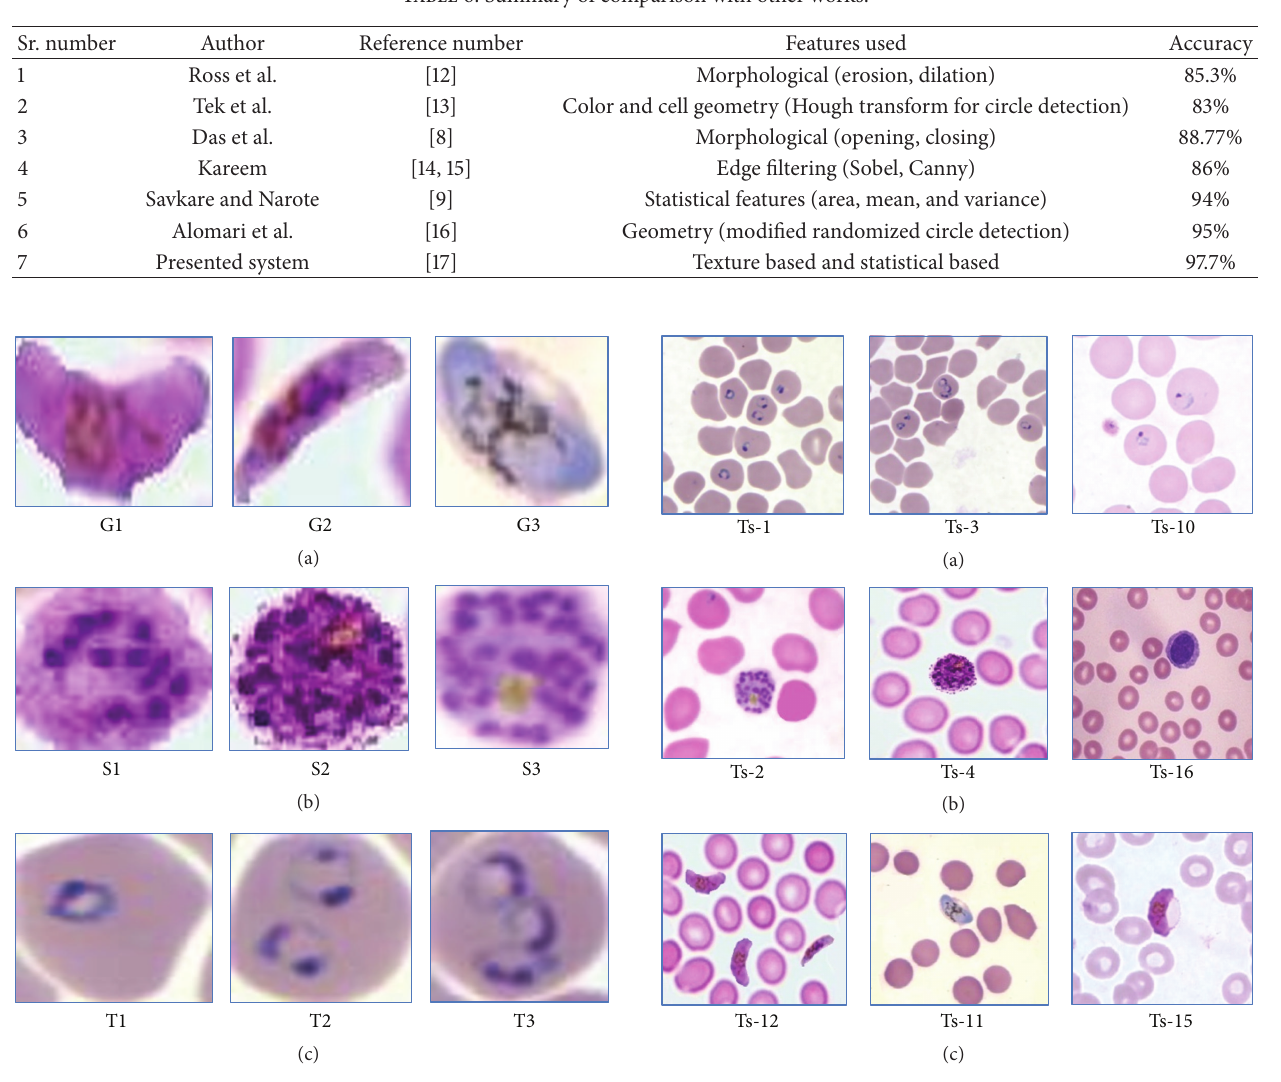
Table 6: Summary of comparison with other works.